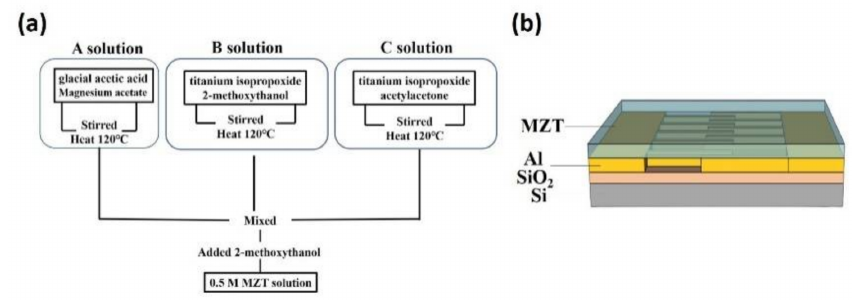
Figure 1. ( a ) Flow chart for preparation of 0.5 M MZT solution. ( b ) Schematic of the MZT/Al/SiO 2 /Si device and the measurement setup.